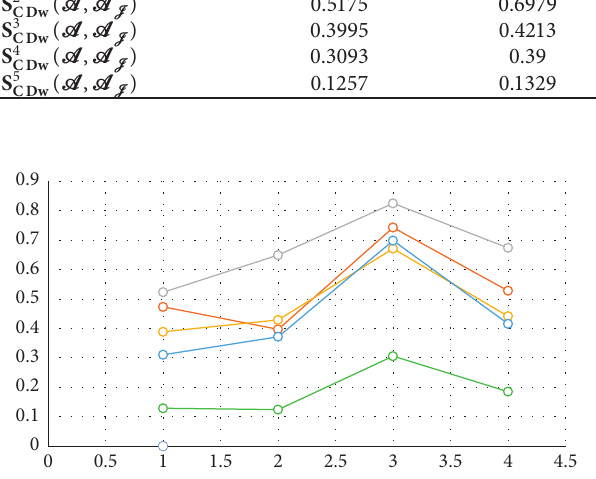
Figure 1: The graphical portrayal of the interpreted SMs between ( J � 1 , 2 , 3 , 4 ) . A and A J